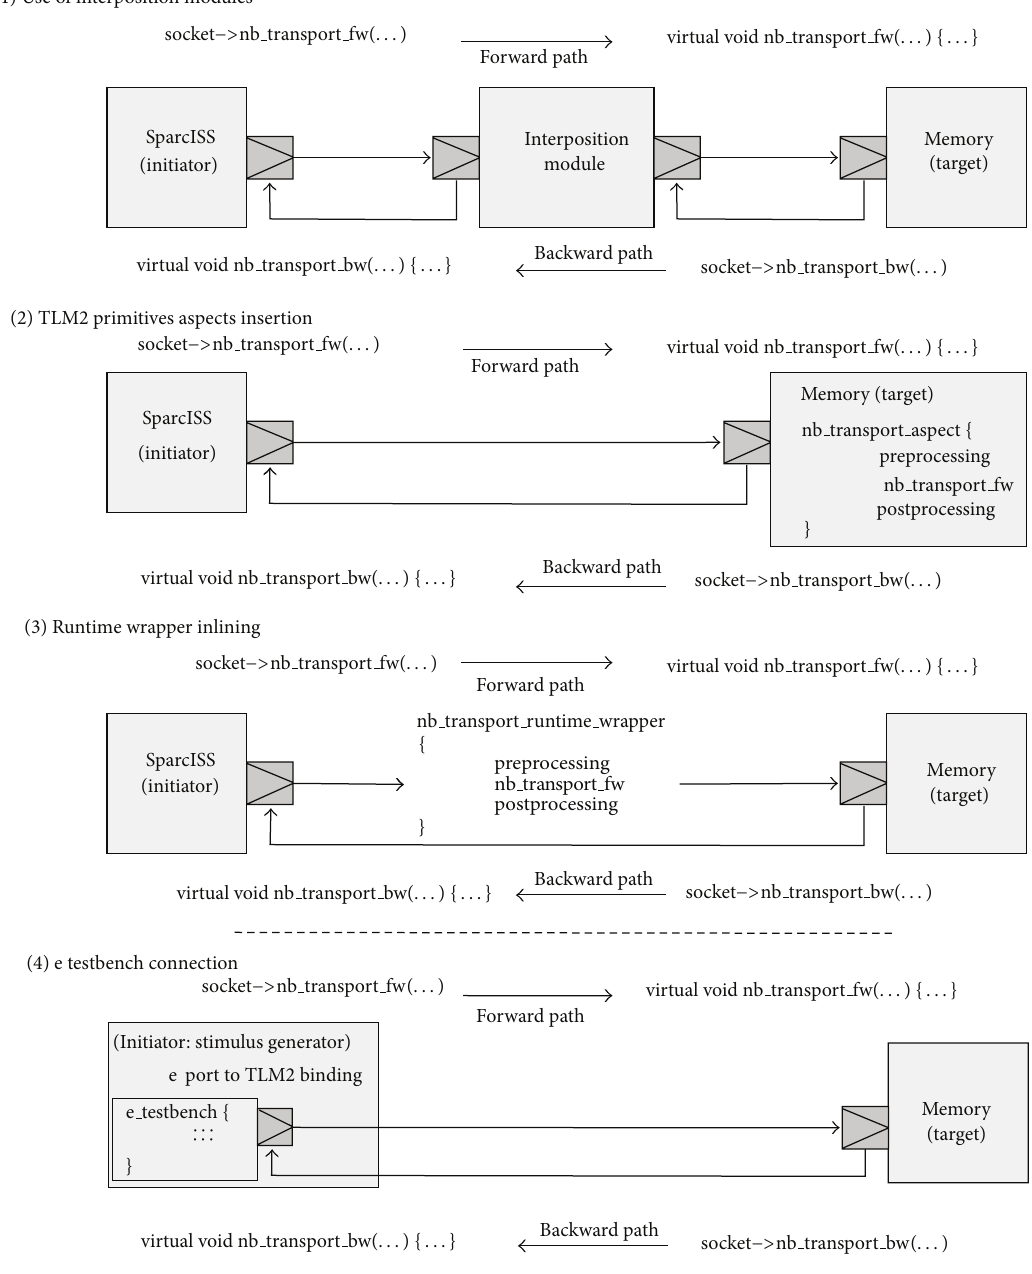
Figure 2: Interposition techniques and testbench